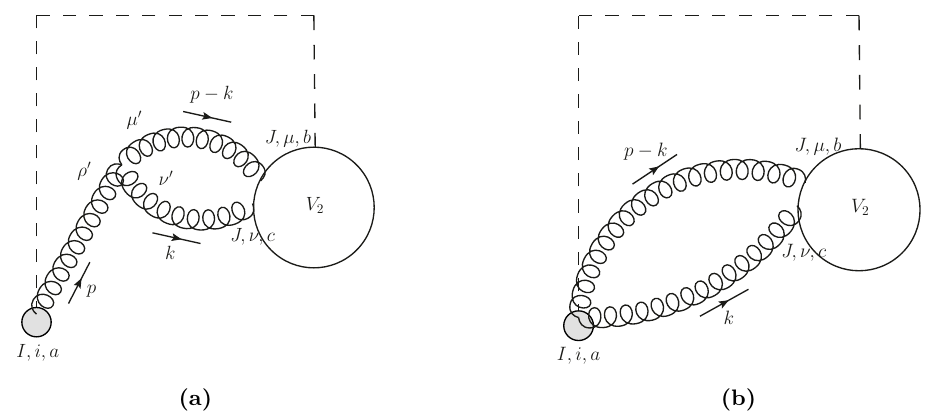
Figure 6. Diagrams with O ((1 − ξ ) 2 ) gauge dependence, with V 2 an arbitrary 2-gauge boson vertex to which the electric field, represented by the grey blob on the left, is connected in either of the two ways (a) and (b)